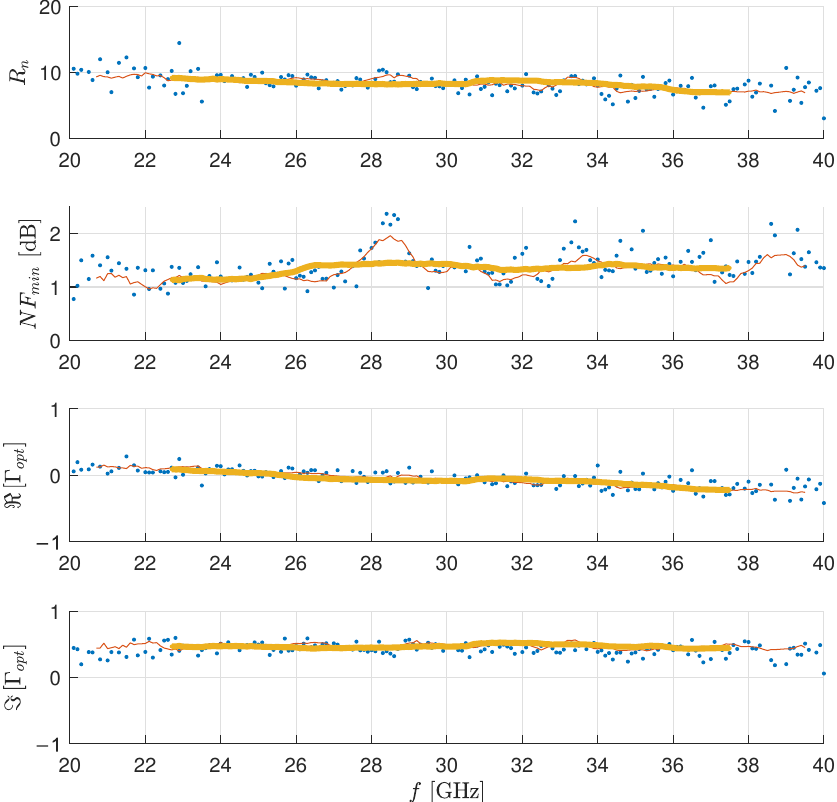
Figure 4. Conversion of the noise correlation matrix to the noise parameters over frequency. Points: physically sound subset of the standard extraction. Continuous thin lines: linearization-based extraction ( f 1 = f 0 − 0.5 GHz, f 2 = f 0 + 0.5 GHz). Continuous thick lines: linearization-based extraction ( f 1 = f 0 − 2.5 GHz, f 2 = f 0 + 2.5 GHz).